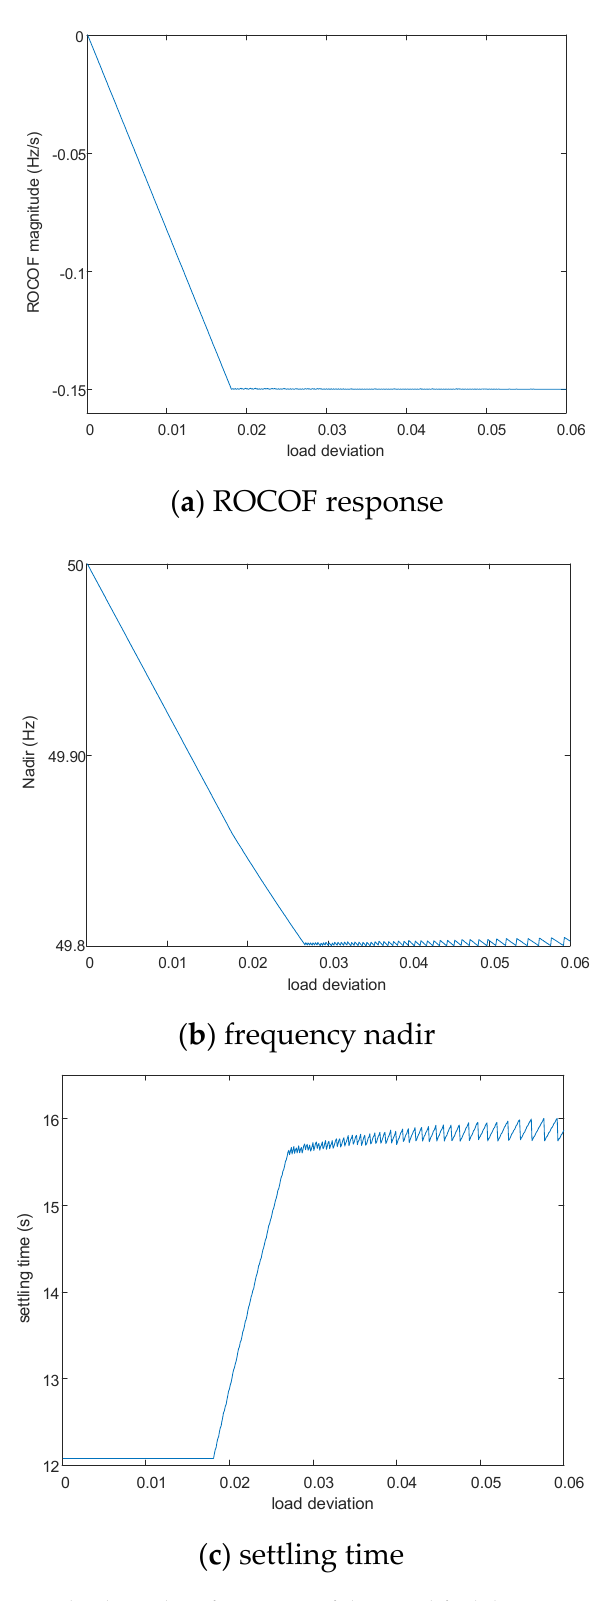
Figure 15. Theological performances of the simplified dynamic system.